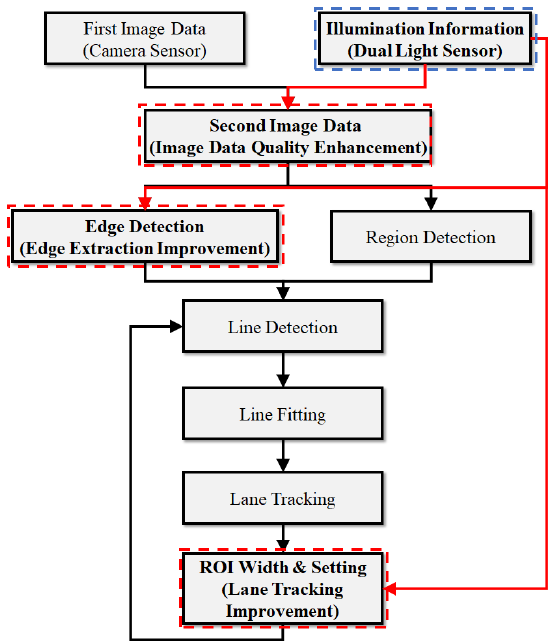
Figure 9. Block diagram of the proposed